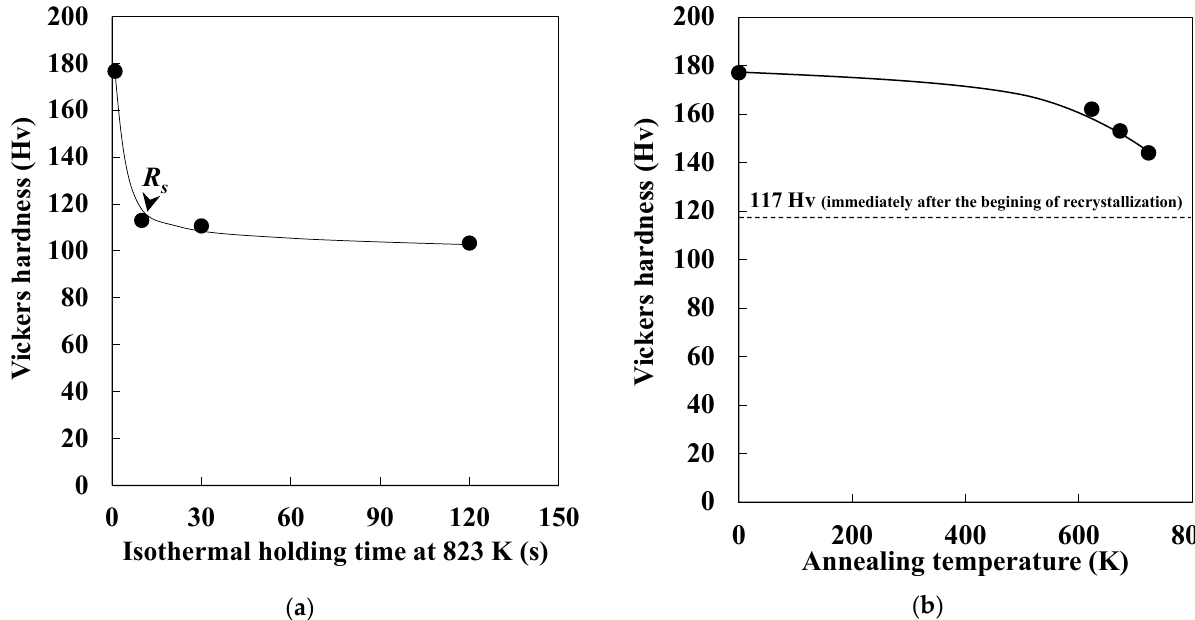
Figure 1. Changes in Vickers hardness as functions of ( a ) isothermal holding time at 823 K and ( b ) annealing temperature ( R s : recrystallization starting time).